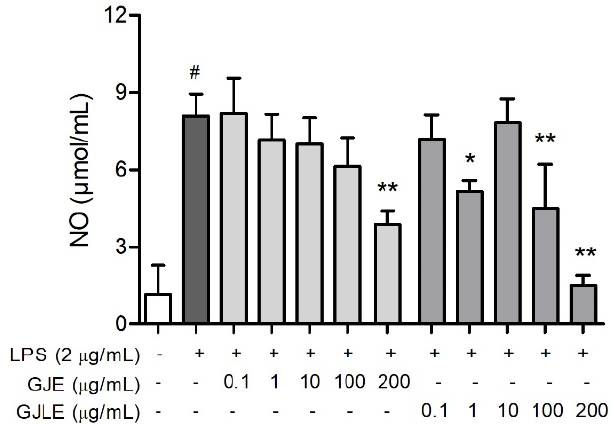
Figure 4. Effect of G. jasminoides and G. jasminoides f. longicarpa flower essential oils on the NO secretion of MH-S cells. Values represent the mean ± SD from three independent experiments, * p < 0.05 and ** p < 0.01 vs. the control treatment group with LPS; # means p < 0.05 vs. the control treatment group without LPS. One-way ANOVA was used, and Duncan test was used for post hoc analysis.